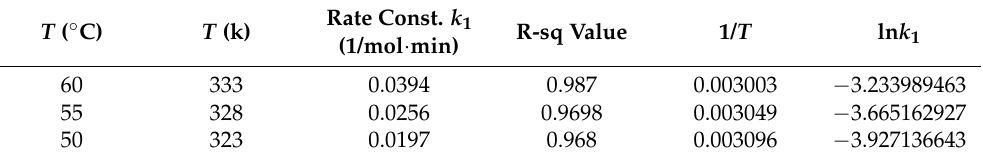
Table 3. Determination of 1/ T and ln k 1 for the WCO transesterification kinetics.